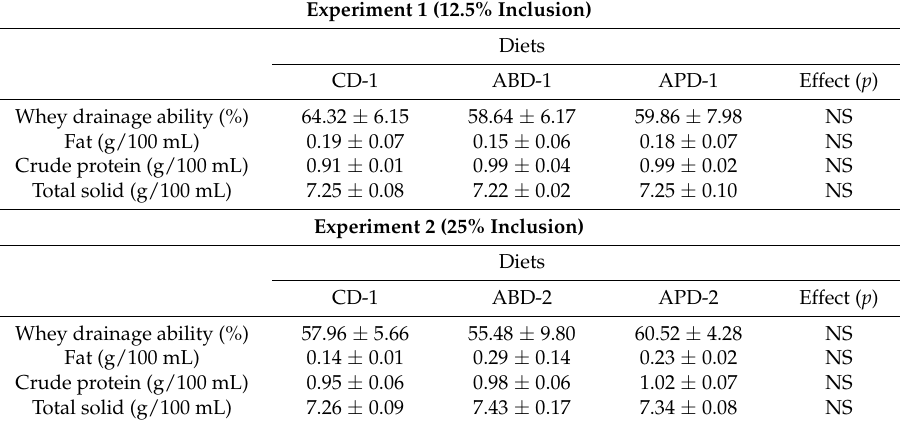
Table 6. Whey drainage ability (%) of milk and whey composition (fat, crude protein and total solid) for rennet coagulated gels from Murciano-Granadina goats fed on diets containing or not containing artichoke by-products (plant and outer bracts) in Experiment 1 (12.5% inclusion) and Experiment 2 (25%